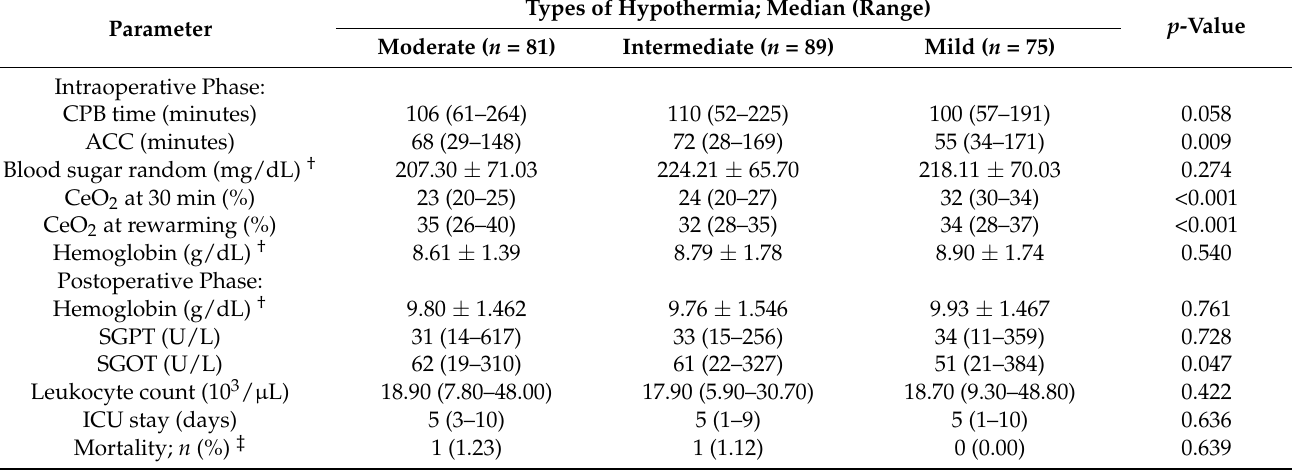
Table 4. Intraoperative and postoperative characteristics of patients undergoing cardiopulmonary bypass